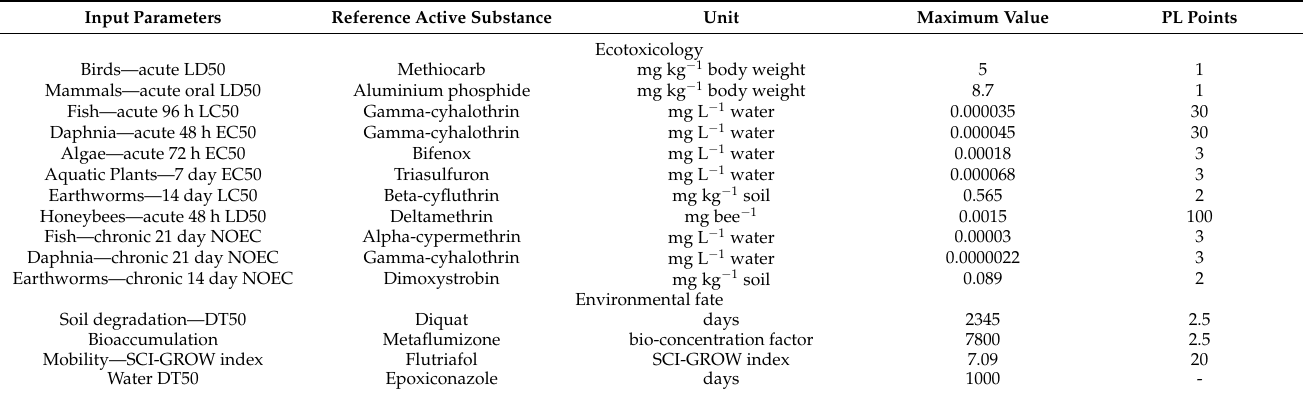
Table 3. Parameters included in the calculation of the Pesticide Load